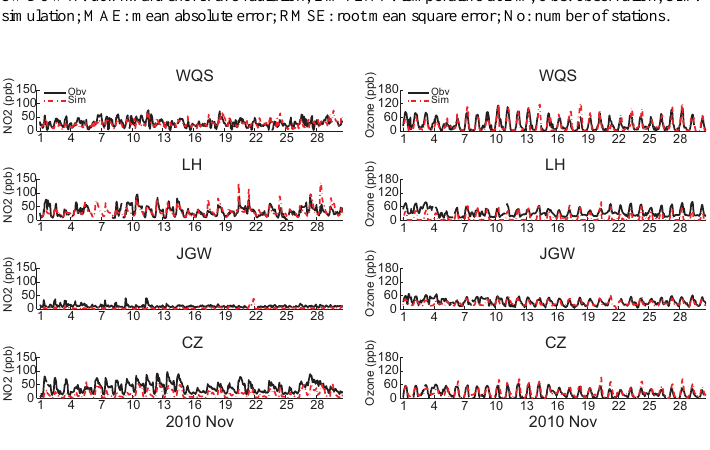
Fig. 3. The simulated and observed hourly nitrogen dioxide (NO 2 ) and surface ozone at 4 PRD monitoring sites in November 2010 (the location of the sites are shown in Fig.